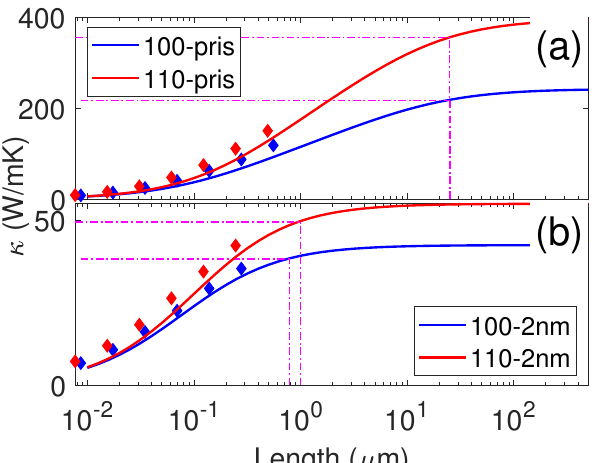
Figure 5. The length-dependent TC along the [100] and [110] crystallographic directions for the pristine ( a ) and resonant ( b ) membranes. The diamond symbols with the corresponding colors are the NEMD results from Ref. [41]. The horizontal dash lines denote the value of 90% of the total TC for each case and the vertical dash lines denote the corresponding